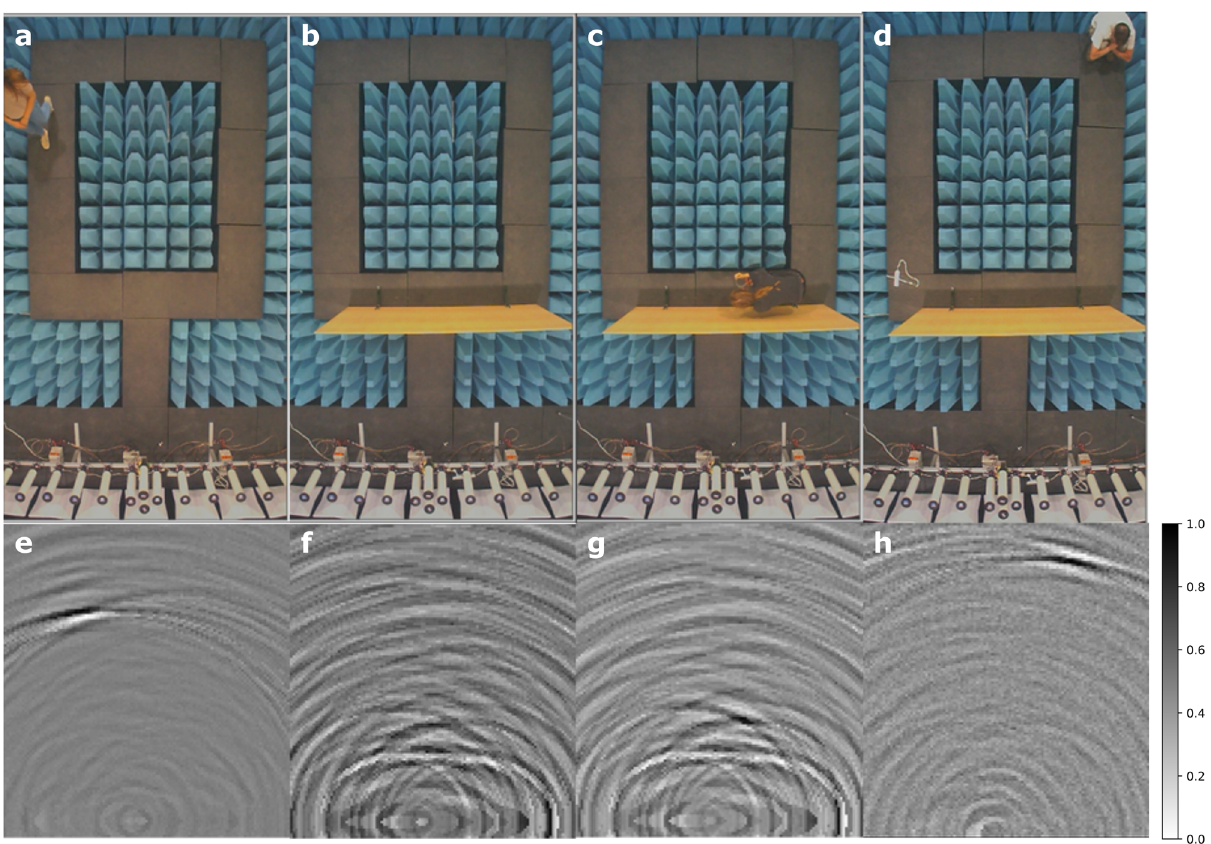
Fig. 7 Experimental demonstration. Ground truth images from a camera mounted 5 m above the scene with a person ( a ), a wall ( b ), a person behind a wall and no wall background subtraction ( c ), and a person behind a wall with background subtraction ( d ). The corresponding fi rst-order reconstructions and gray scale bars for panels a , b , c , and d set are shown, respectively, in panels e , f , g , and h